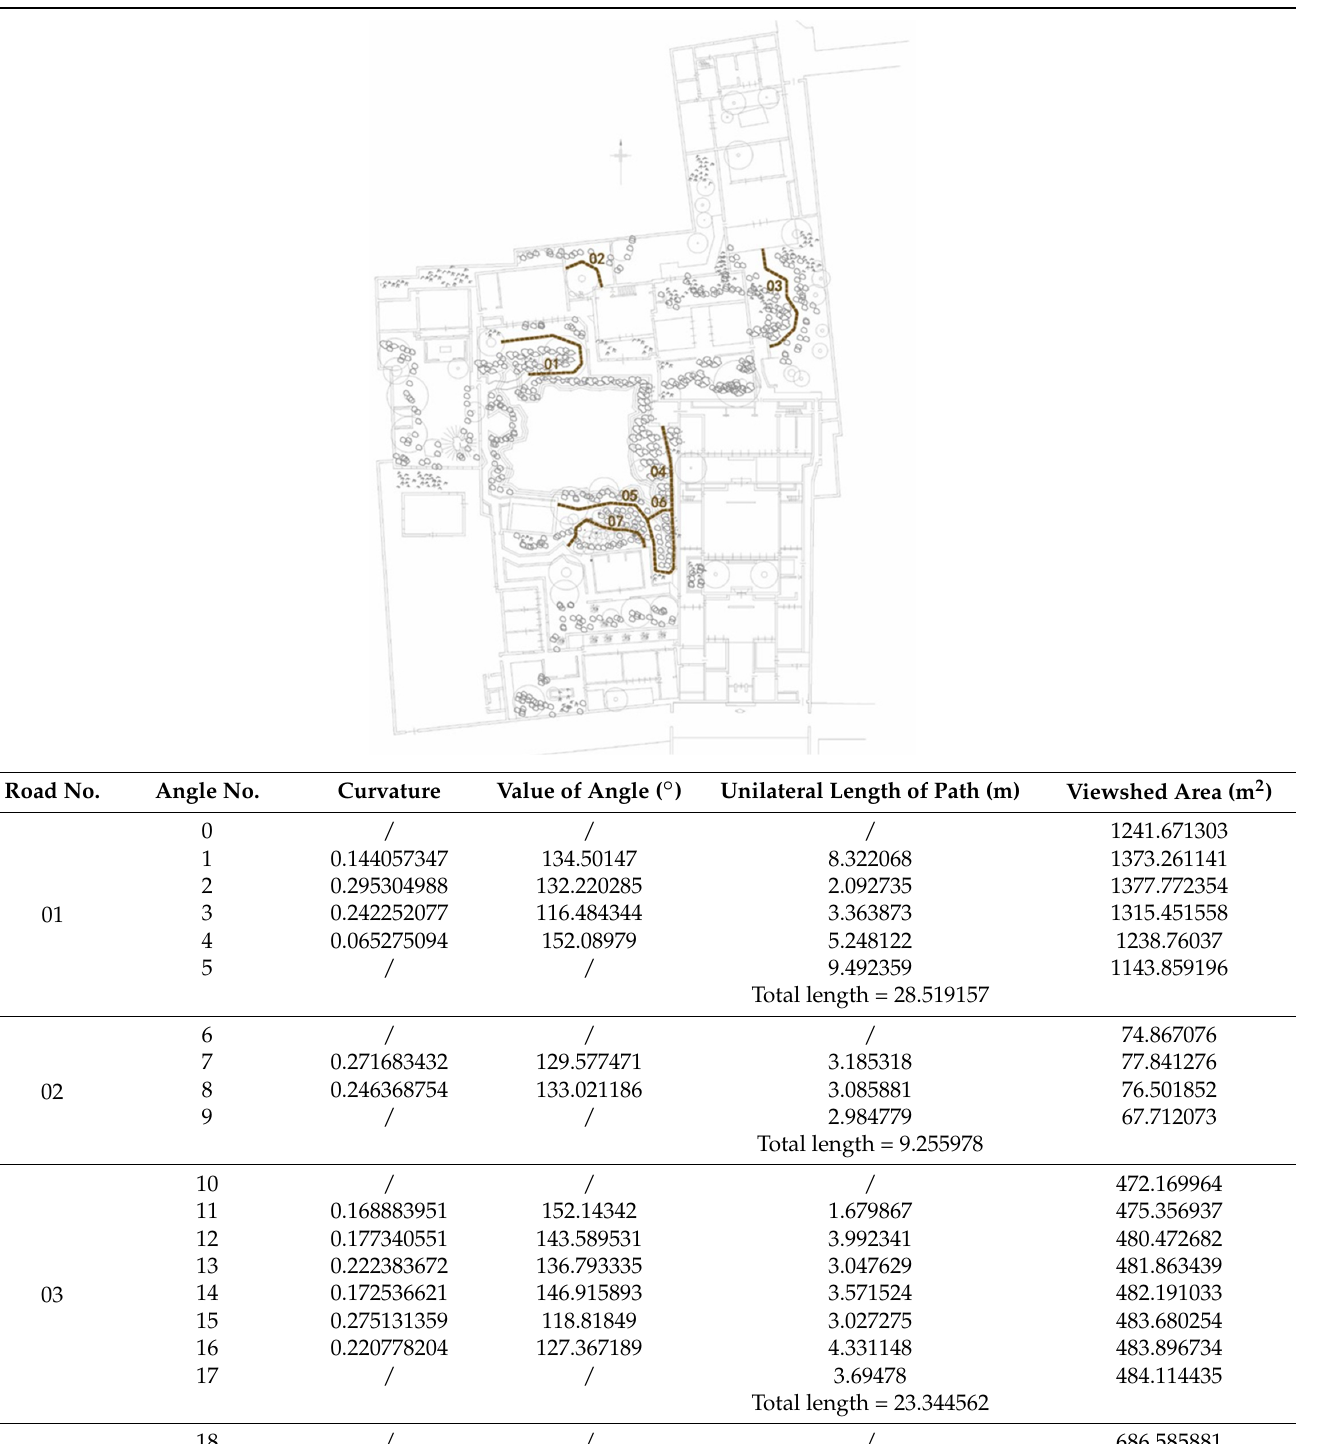
Table A5. Master of the Nets Garden, garden path.